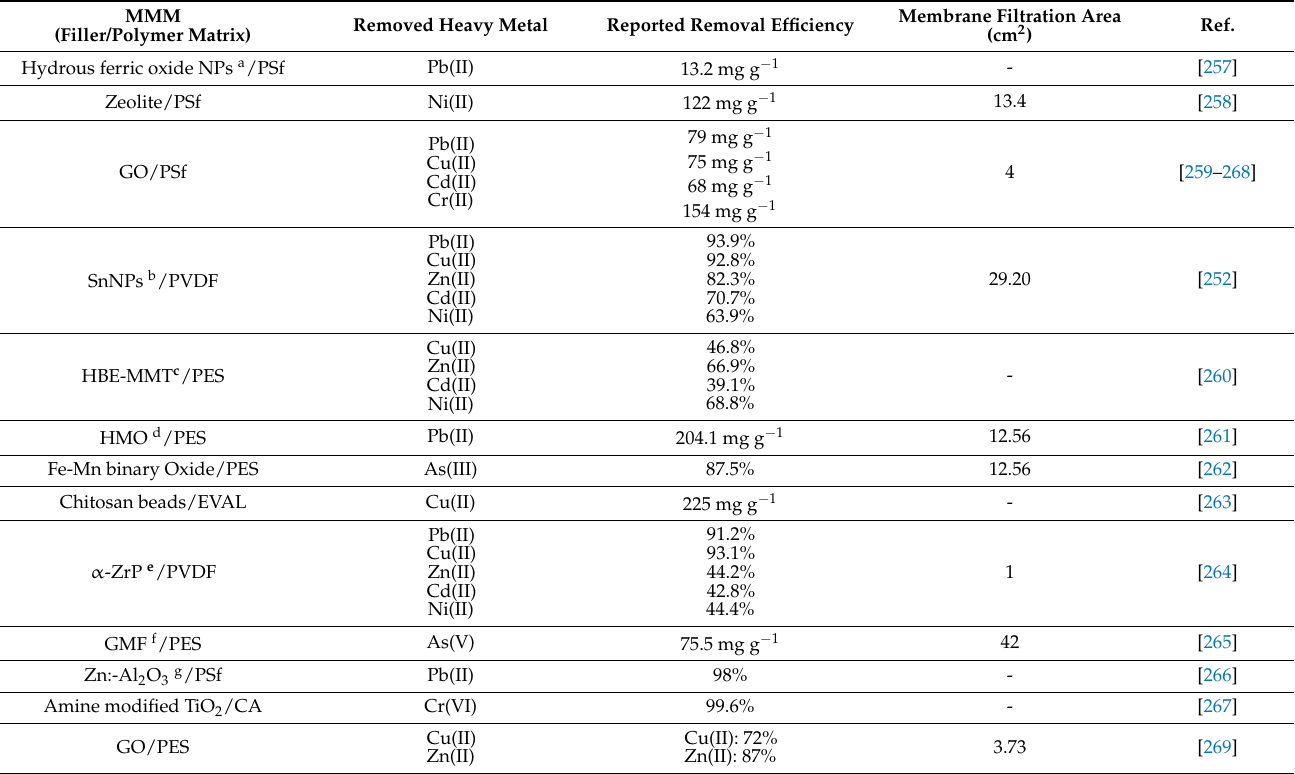
Table 8. Characteristics of some adsorptive MMMs for heavy metal and metalloid